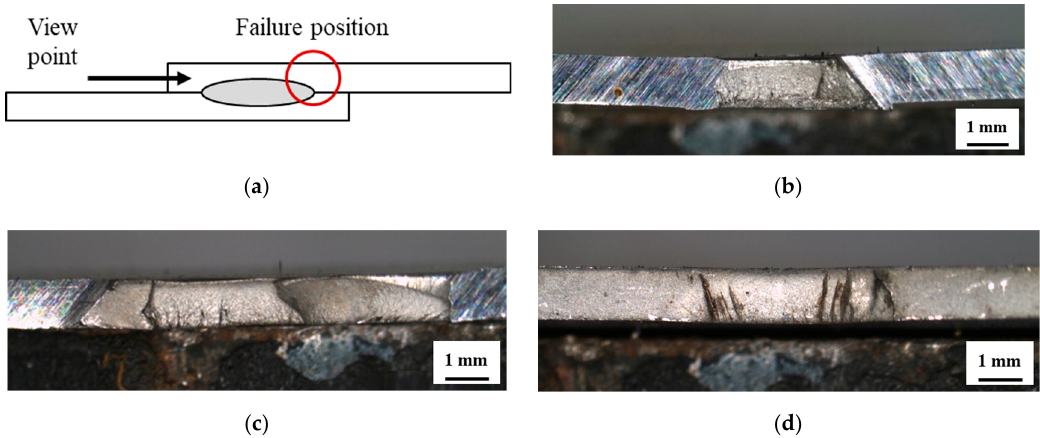
Figure 10. ( a ) Schematic diagram indicating fracture position (red circle) and view direction (black arrow). Fracture surface images with various failure types: ( b ) pull-out failure, ( c ) plug failure, and ( d ) HAZ failure.